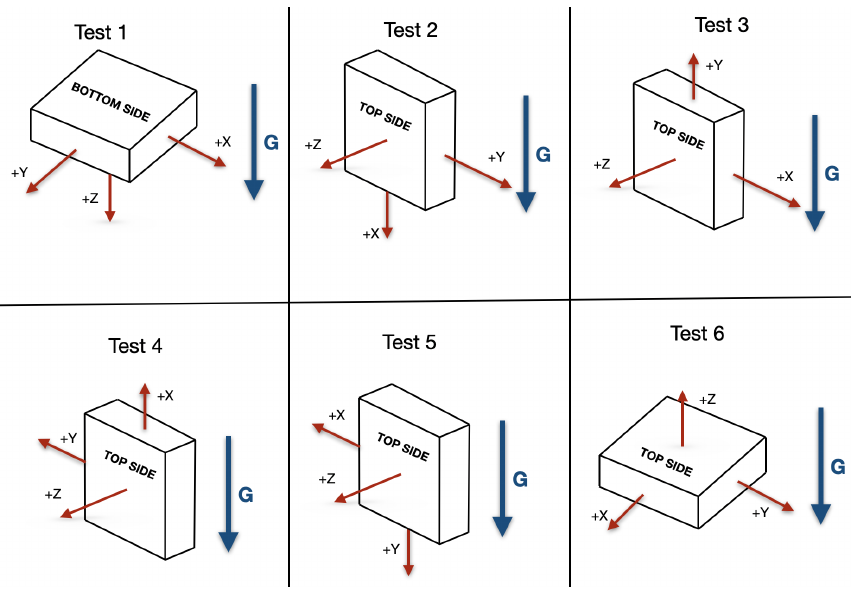
Figure 5. Orientations during the six calibration tests.